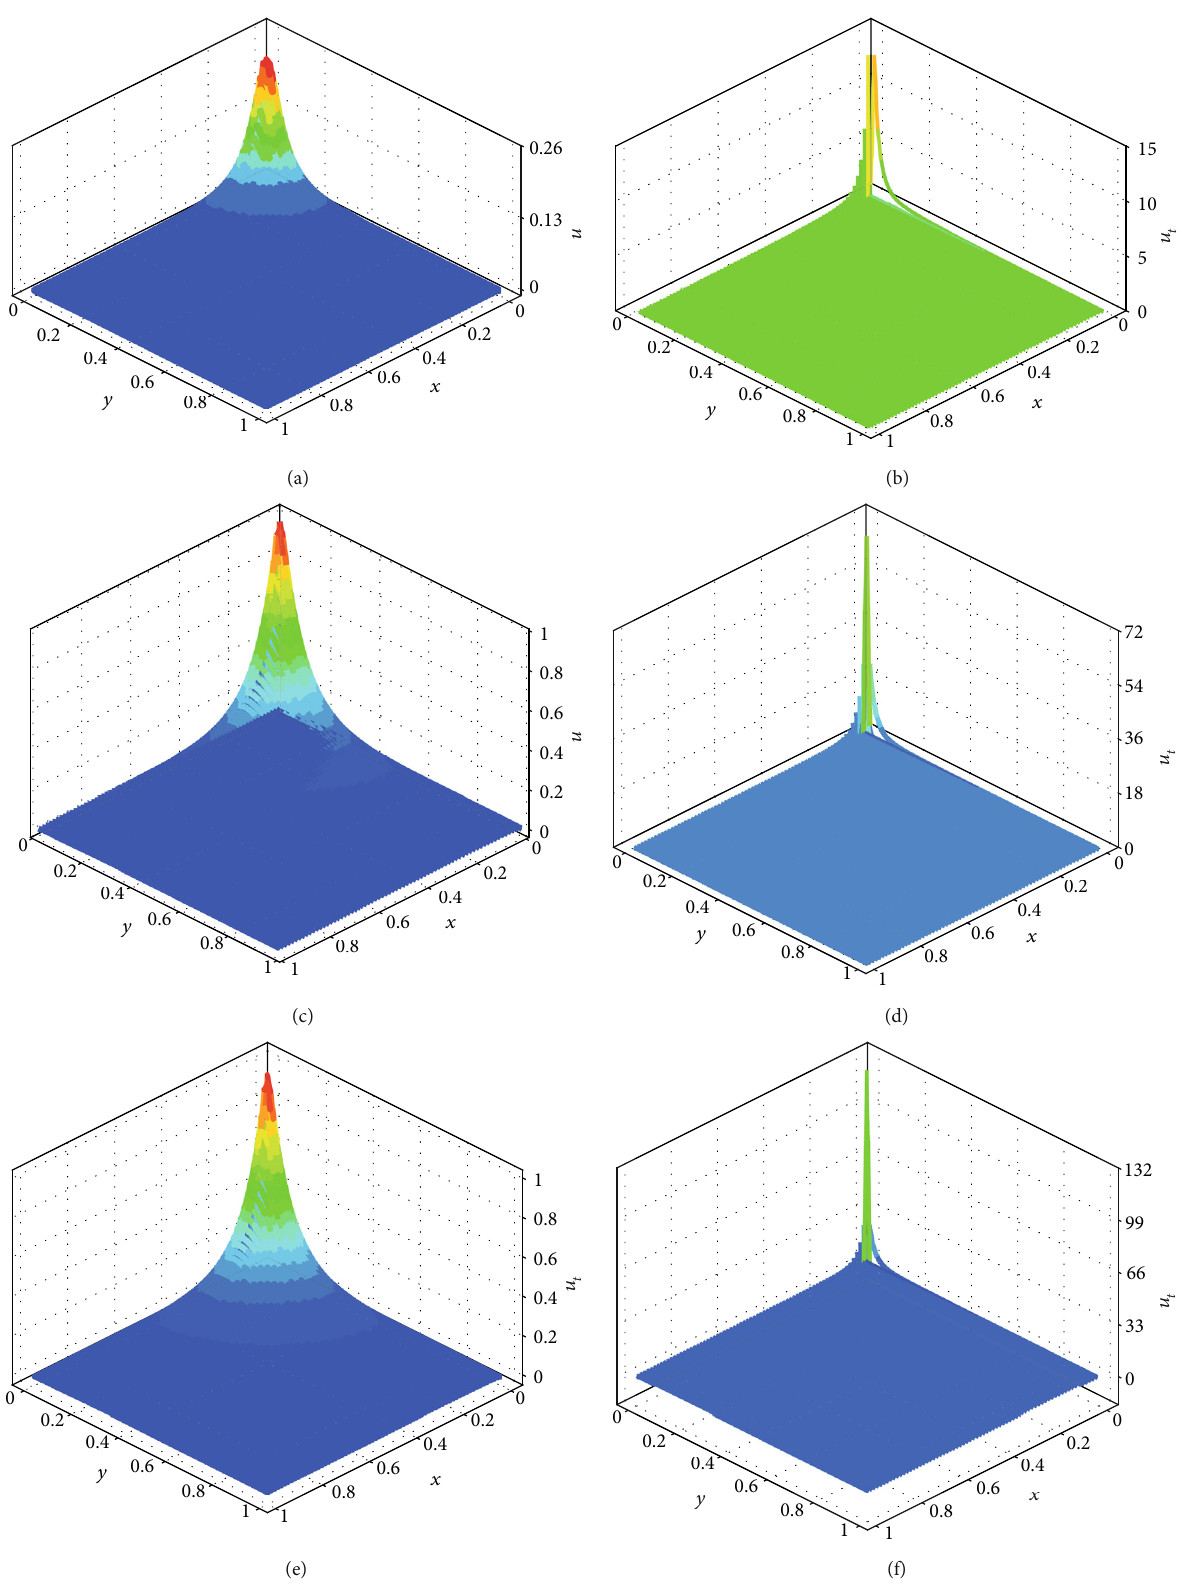
t = 0 : 40 ; (c) the 3D plot of u when t = 3 : 428342645817735 ; (d) the 3D Figure 5: (a) The 3D plot of u when t = 0 : 40 ; (b) the 3D plot of u t when plot of u t when t = 3 : 428342645817735 ; (e) the 3D plot of u when t = T 5 ∗ ; (f) the 3D plot of u t when t = T 5 ∗ . All is for Case